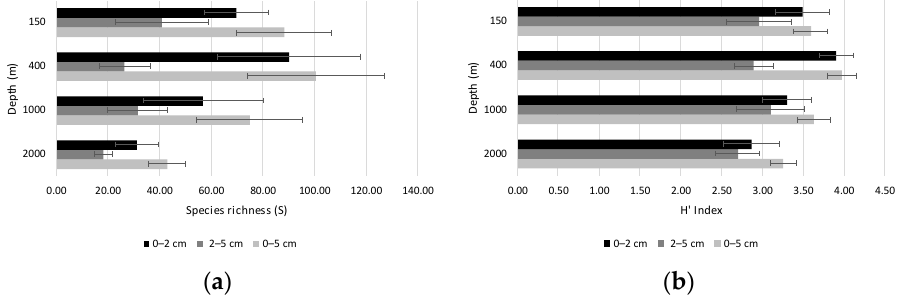
Figure 6. The mean and standard deviation of foraminifera species diversity along the studied isobaths at the surface, subsurface, and integrated layer. ( a ) Species richness; ( b ) Shannon’s index. The higher H’ diversity index values occurred at the surface layer; the highest was registered at 400 m (H’= 4.18, MT65) while the lowest at 2000 m (H’ = 2.49, MT82) (Figure 6b). H’ diversity had few changes at the subsurface layer; the highest value occurred at 1000 m (H’ = 3.49, MT72), and the lowest at 2000 m (H’ = 2.31, MT84). The subsurface layers showed higher equitability (J’) mean values, increasing towards the deep sea, except at 150 m, where both layers presented the same average ( x = 0.82 ± 0.06 in surface and x = 0.82 ± 0.1 in subsurface). At the surface layer, the lower values were registered at 150 m (Figure 7a).